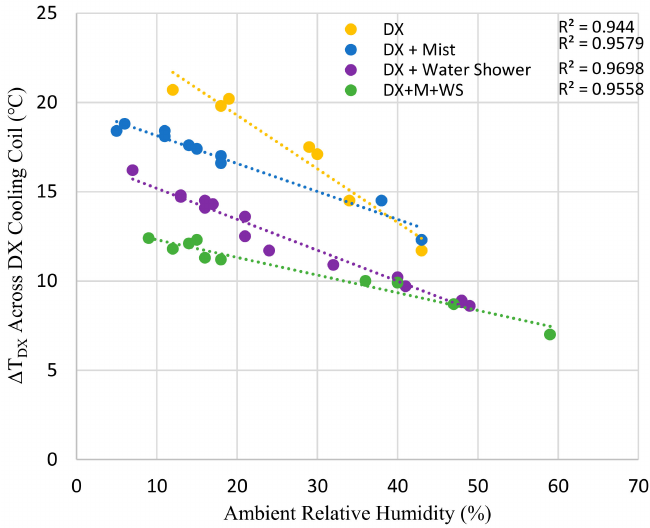
Figure 12. Variation of ∆ T DX across the DX cooling coil with relative humidity for ambient temperatures higher than 40 ◦ C.